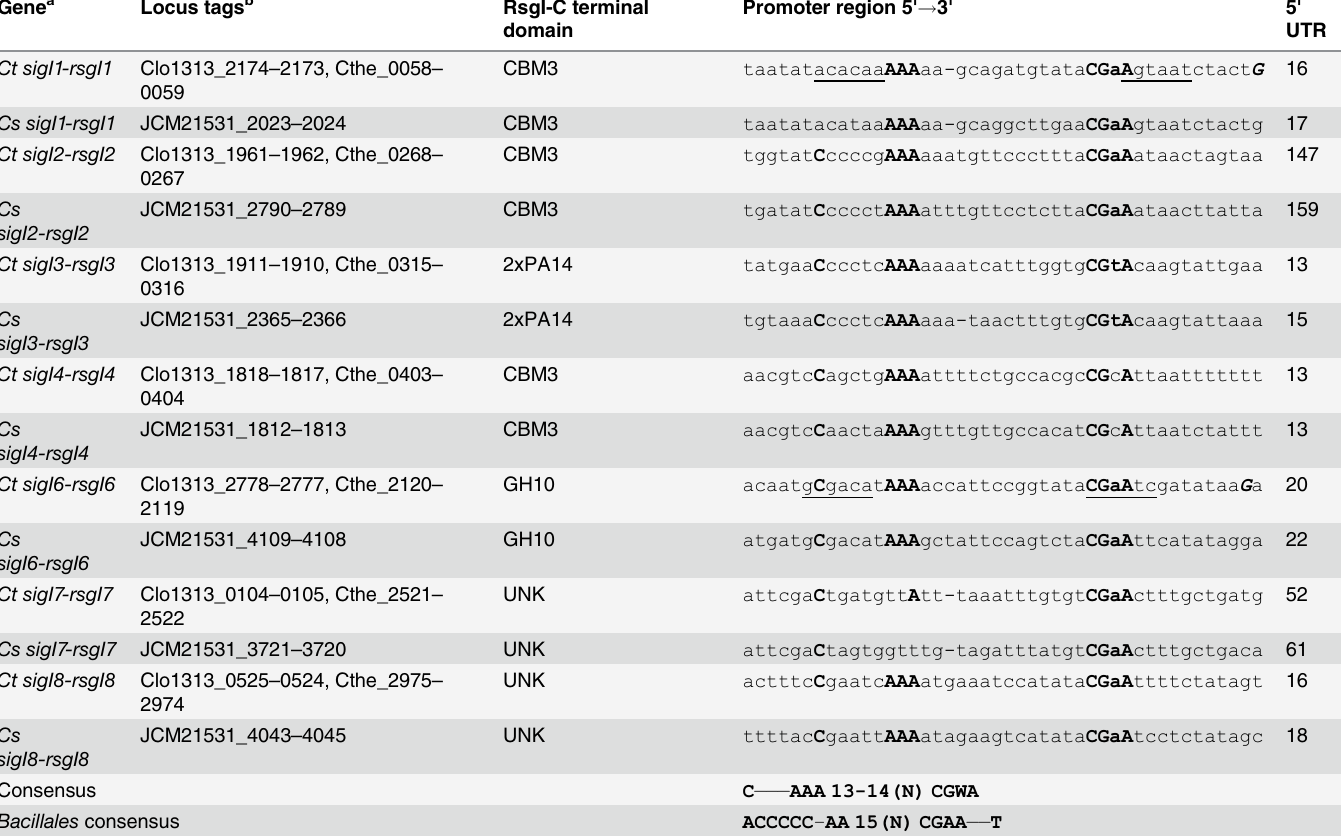
Table 1. Alignment of putative C . thermocellum and C . straminisolvens sigI promoters. Gene